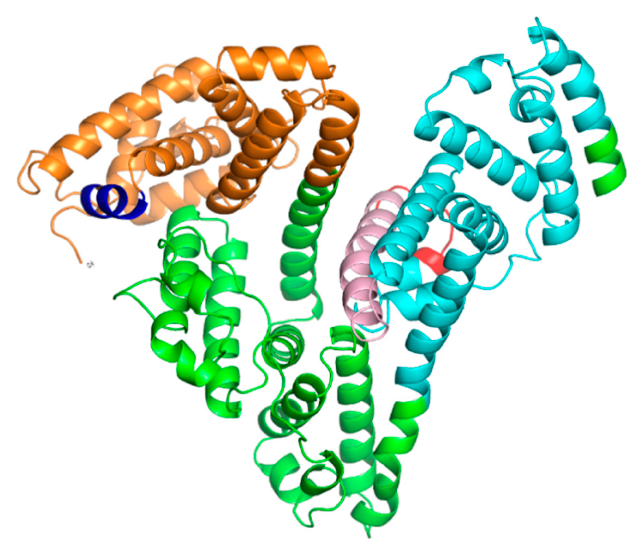
Figure 1. The overall architecture of AFP is represented by a U-shaped structure composed of three domains: I (orange, residues 19–210), II (green, residues 211–402), and III (cyan, residues 403–601). Two functionally important segments, AFP 14–20 with sequence LDSYQCT (residues 32–38, colored in blue) and GIP-9 with sequence EMTPVNPGV (residues 489–497, colored in red) that is a part of GIP-34 (residues 464–497, colored in pink), respectively, are shown. The fist peptide segment is located in the domain I, close to N -terminus, and arranged in α -helical conformation. The second segment encompasses C -terminal part of GIP-34 part of secondary structure elements of the GIP-9 peptide is arranged in α -helix, while the remaining part represents a disordered region, and this can have a role in its